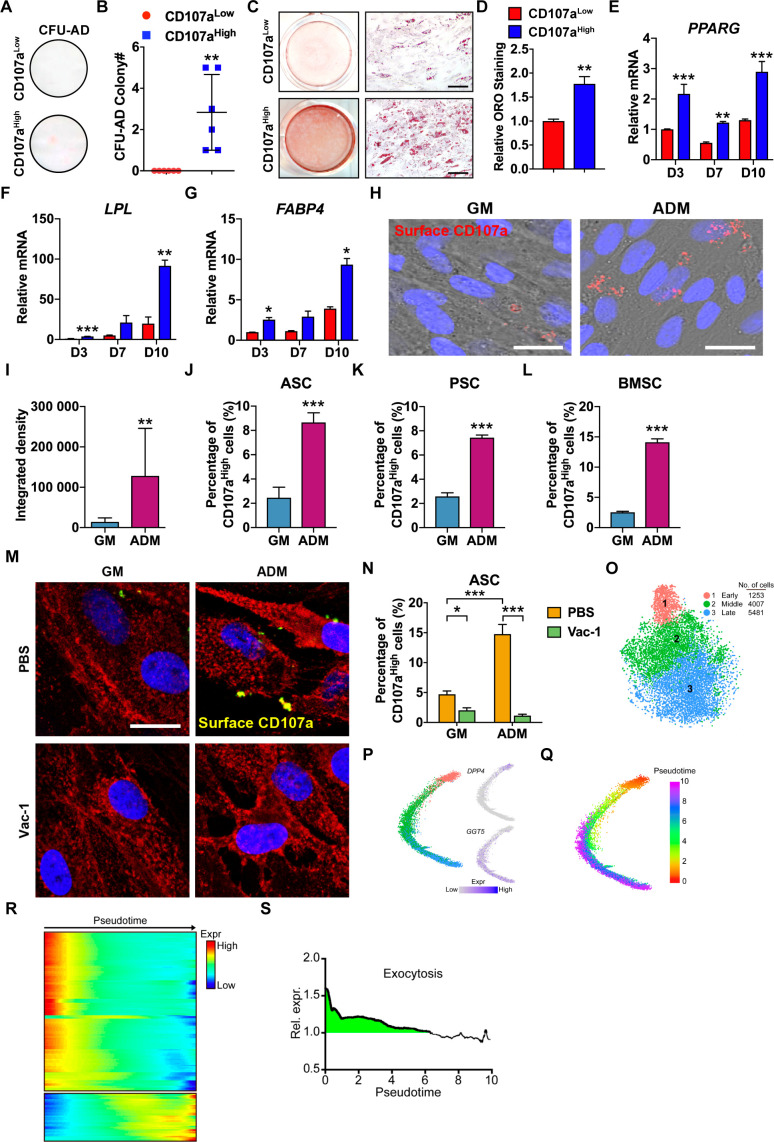
Adipoprogenitor cell identity of CD107ahigh human mesenchymal cells and correlation to exocytosis during early adipogenic differentiation.(A–G) CD107alowCD31-CD45- and CD107ahighCD31-CD45- cells derived from human subcutaneous WAT were exposed to adipogenic differentiation conditions. (A,B) Adipocyte colony formation frequency (CFU-AD) detected in human CD107alow and CD107ahigh cells. Whole well images shown. (C,D) Oil red O (ORO) staining and photometric quantification at d7 of adipogenic differentiation among human CD107alow and CD107ahigh cells. Representative whole well and high magnification images shown. (E–G) Adipogenic gene expression among human CD107alow and CD107ahigh cells by qRT-PCR at d 3, 7, and 10 of differentiation, including (E) Peroxisome proliferator-activated receptor-γ (PPARG), (F) Lipoprotein lipase (LPL), and (G) Fatty acid-binding protein 4 (FABP4). (H) Immunocytochemical staining of membranous CD107a in the presence of growth medium (GM) or adipogenic differentiation medium (ADM) after 3 d using human, culture-defined adipose-derived stem cells (ASCs). CD107a immunoreactivity appears red, nuclear counterstain appears blue. (I) Photographic quantification of membranous CD107a immunofluorescence under GM or ADM conditions. (J–L) Induction of membranous CD107a expression after adipogenic differentiation across cell types, including (J) culture-defined human ASCs, (K) FACS-purified human perivascular stem cells (PSC), and (L) culture-defined human BMSCs, assessed by flow cytometry after 3 d under GM or ADM conditions. (M,N) Trafficking of CD107a to the cell surface during adipogenesis was inhibited after treatment with Vacuolin-1 (Vac-1, 1 μM), assessed by CD107a immunostaining (M) and flow cytometry (N) after 3 d under GM and ADM conditions. The cell membrane was labeled using Wheat Germ Agglutinin Conjugates (red), while overlap with CD107a immunostaining appears yellow, and DAPI nuclear counterstain appears blue. (O) Dimensional reduction and unsupervised clustering of human stromal vascular fraction (SVF) adipogenic lineage from subcutaneous WAT revealed three cell groups. (P) Trajectory analyses of human SVF adipogenic lineage, colored based on their unsupervised clustering identity. DPP4 (early) and GGT5 (late) expression were used to identify trajectory origin. (Q) Pseudotemporal cell ordering along differentiation trajectories. Pseudotime is depicted from red to purple. (R) Expression heatmap across pseudotime of genes associated with exocytosis. (S) Combined, normalized expression of exocytosis genes shows enrichment (>1) in early progenitors (green shaded area), while more differentiated cells show reduced average expression. Dots in scatterplots represent values from individual wells, while mean and one SD are indicated by crosshairs and whiskers. In column graphs, mean values and one SD are shown. *p<0.05; **p<0.01; ***p<0.001. Statistical analysis was performed using a two-tailed Student t-test (B,D,I–L) or two-way ANOVA followed by Sidak’s multiple comparisons test (E–G,N). Experiments performed in at least biologic triplicate. Black scale bar: 100 μm; white scale bar: 20 μm.